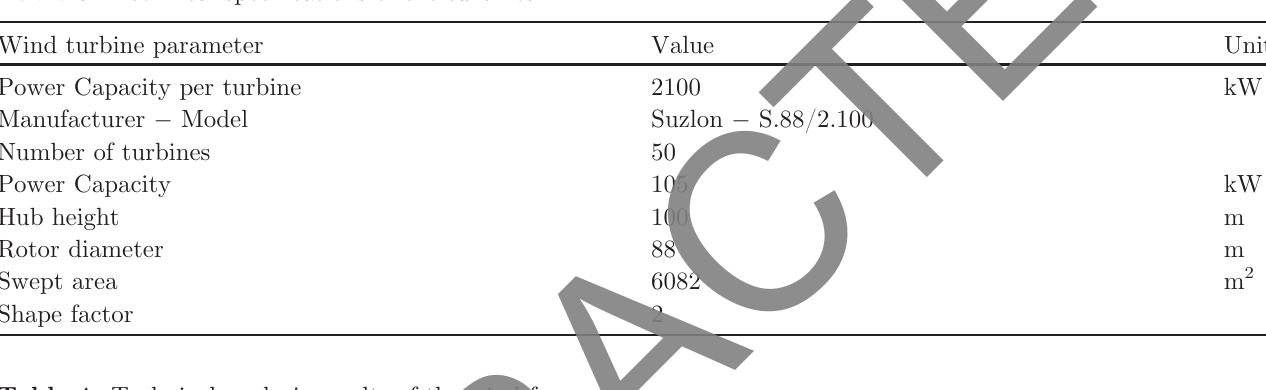
Table 4. Technical analysis results of the wind farm. Parameter